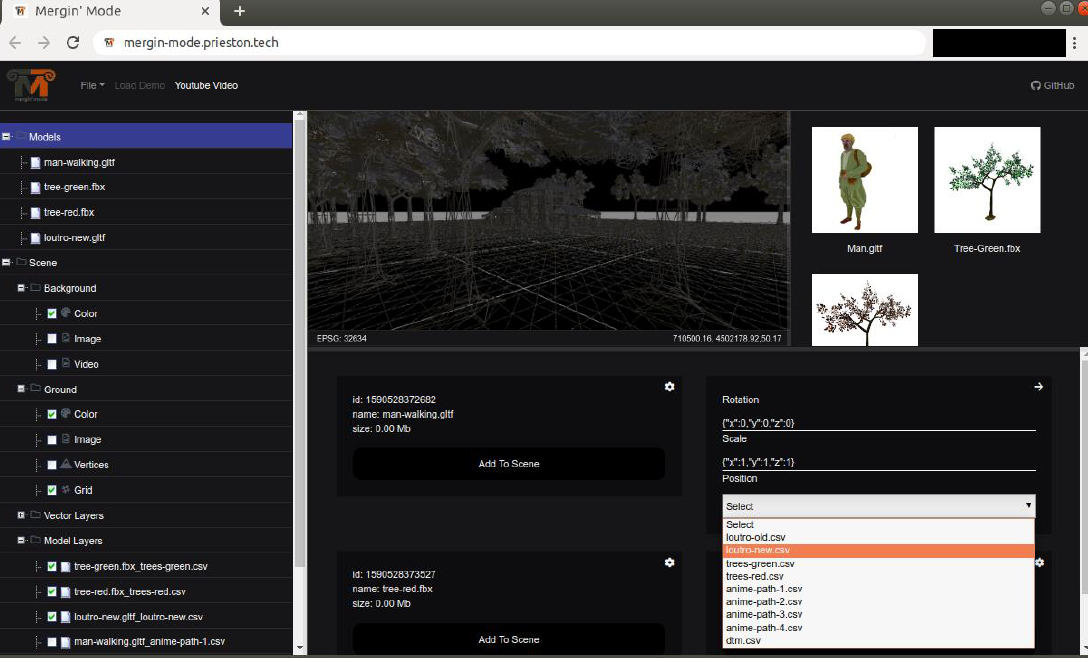
Figure 7. An overview of “Mergin’ Mode” authoring tool user interface.